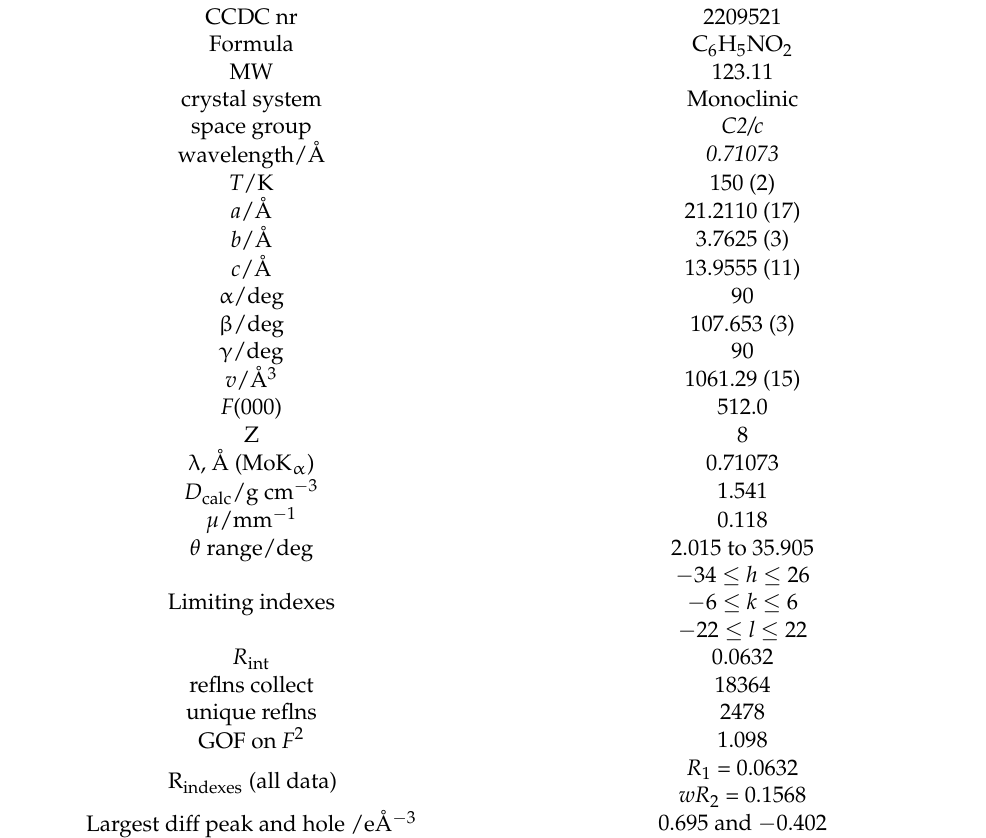
Table 1. Crystal data and structure refinement parameters for the